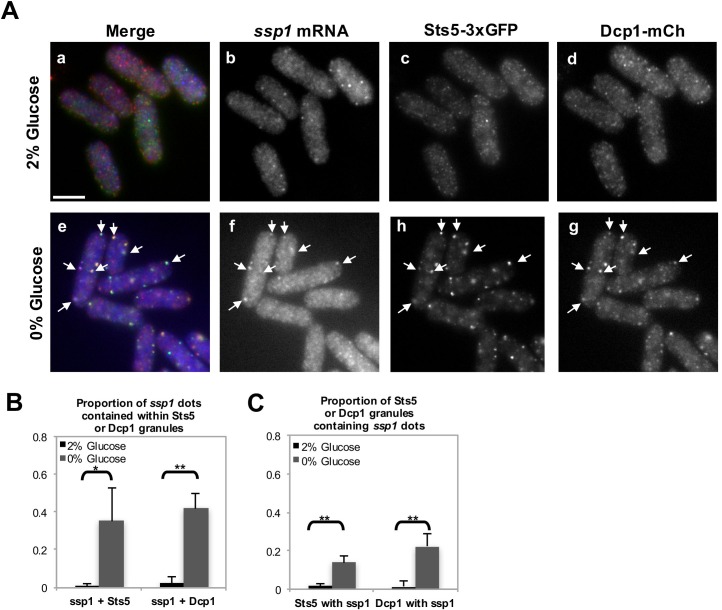
Extent of colocalization between ssp1 mRNA, Sts5-3xGFP, and Dcp1-mCherry in fixed cells cultured in the presence and absence of glucose.(A) RNA FISH visualization of ssp1 mRNA in fixed cells cultured for 20 min in supplemented minimal medium containing 2% glucose or 0% glucose. Hybridization used 20-mer DNA oligos (Stellaris) labeled with Quasar 705 fluorochromes. Bar = 5 μm. (B) Object-based quantification of the proportion of ssp1 puncta contained within Sts5-3xGFP or Dcp1-mCherry puncta in the presence and absence of glucose. For ssp1 dots contained within Sts5 granules in 0% glucose vs 2% glucose, P = 0.0293 (Student’s t-test). For ssp1 dots contained within Dcp1 granules in 0% glucose vs 2% glucose, P = 0.0011 (Student’s t-test). Object-based quantification based on the distance between centers of mass performed using ImageJ plugin JACoP (Bolte and Cordelières, 2006). Error bars denote SD among the means of 3 independent experiments (N≥25 cells). For details, see Materials and methods. (C) Object-based quantification of the proportion of Sts5-3xGFP or Dcp1-mCherry puncta containing ssp1 puncta in the presence and absence of glucose. For Sts5 granules containing ssp1 dots in 0% glucose vs 2% glucose, P = 0.0042 (Student’s t-test). For Dcp1 granules containing ssp1 dots in 0% glucose vs 2% glucose, P = 0.0053 (Student’s t-test). Object-based quantification based on the distance between centers of mass performed using ImageJ plugin JACoP (Bolte and Cordelières, 2006). Error bars denote SD among the means of 3 independent experiments (N≥25 cells). For details, see Materials and Methods.